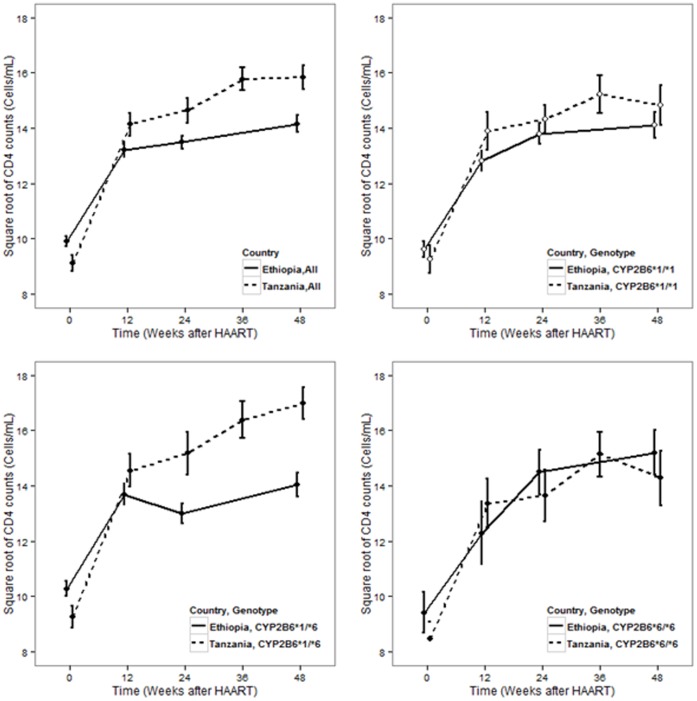
Standard error bar plots for CD4 gain profile among Ethiopian compared to Tanzanian patients, all and stratified by CYP2B6 genotype.